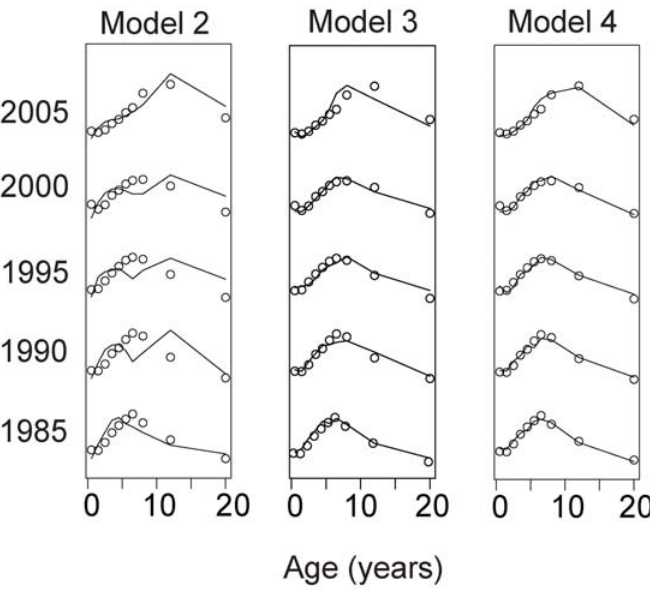
Figure 3. Fit of models to data 1985, 1990, 1995, 2000, 2005, model 2, 3, and 4. Age-specific incidence is shown by circles and fits from model shown by lines. Model 2 includes time-specific but not age-specific forces of infection. Model 3 includes additive age-specific forces of infection in addition to time-specific forces. Model 4 includes multiplicative age-specific forces of infection in addition to time-specific forces.